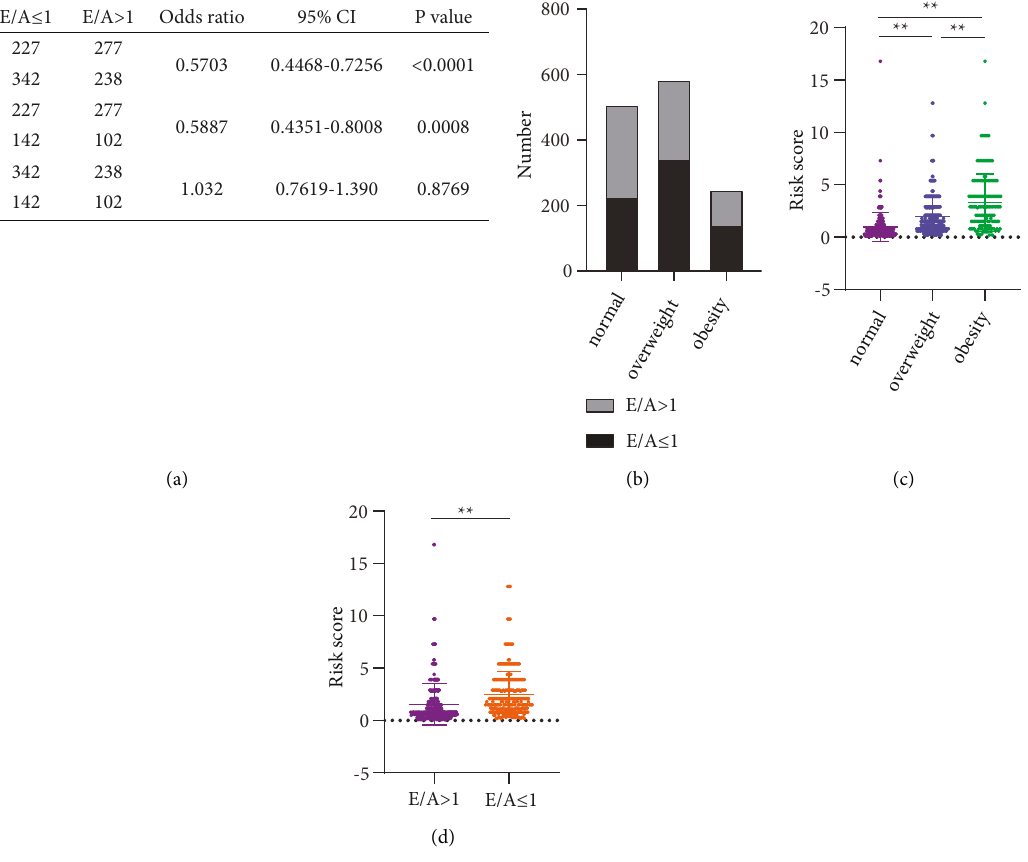
Figure 3: Cardiac ultrasound parameters and cardiovascular risk. (a) Results of chi-square tests for E/A ≤ 1 and E/A > 1 in normal, overweight, and obese populations. (b) Proportions of E/A ≤ 1 and E/A > 1 in normal, overweight, and obese populations. (c) Comparison of cardiovascular risk in normal, overweight and obese populations. (d) Comparison of cardiovascular risk for E/A ≤ 1 and E/A > 1. ∗∗ P < 0 .